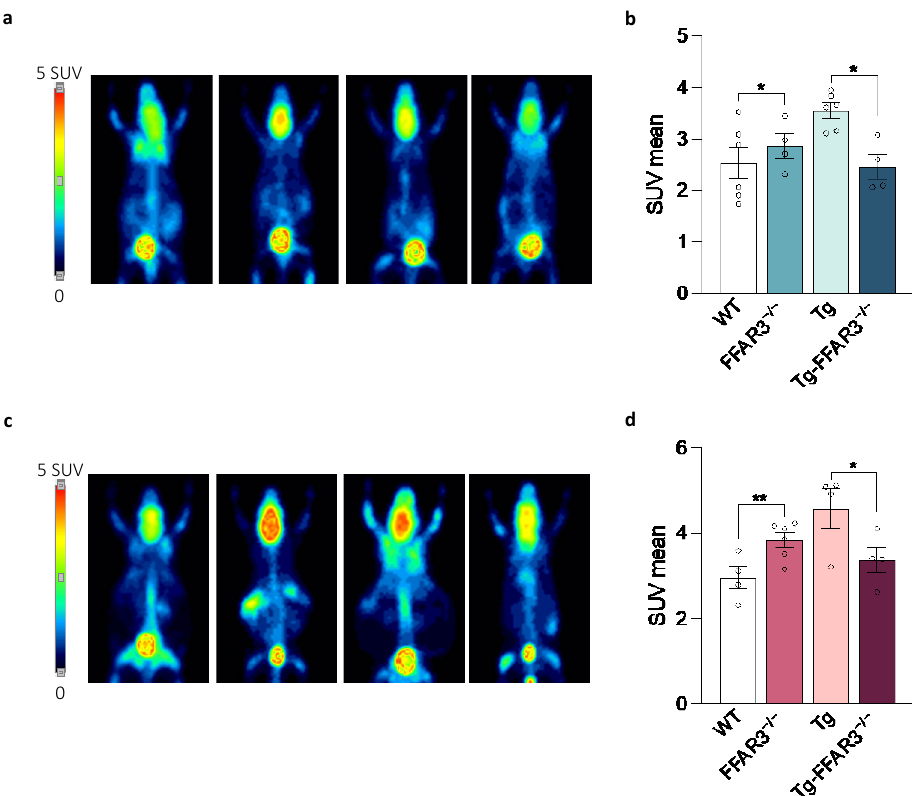
Figure 3. Tg2576 mice exhibit a brain glucose hypermetabolism which is restored upon FFAR3 deletion. ( a ) PET images of representative mice showing brain 18 F-FDG signal in standard uptake value (SUV) and ( b ) the quantification of positron emission (SUV mean) of wild type (WT), FFAR3 knockout (FFAR3 −/− ), Tg2576 (Tg) and Tg2576 FFAR3 knockout mice (Tg-FFAR3 −/− ) fed with NCD. ( c ) PET images of representative mice showing brain 18 F-FDG signal and ( d ) the quantification of positron emission (SUV mean) of mice subjected to HFD. Results are expressed as mean ± SEM and circles in the subfigures represent each individual value ( n = 4–6 in each group). * p < 0.05 and ** p < 0.01, two-way ANOVA followed by Tukey.